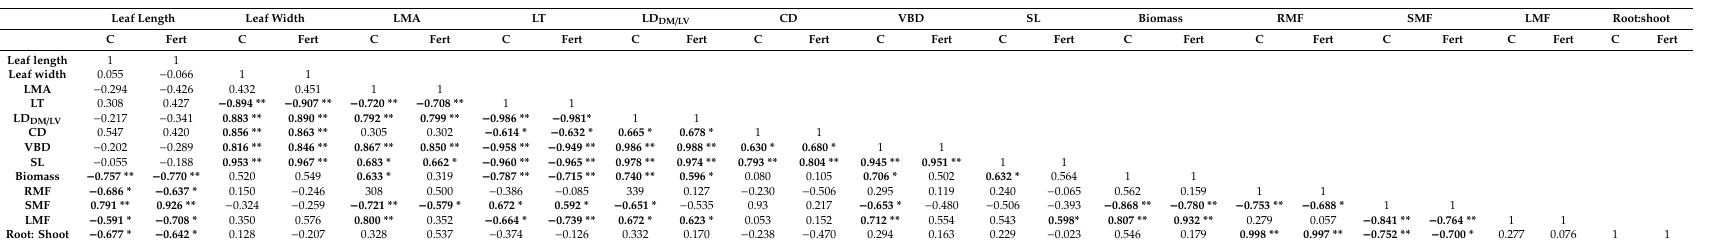
Table 3. Pearson’s correlation coe ffi cients of selected leaf morphological and anatomical traits, biomass and mass fractions of two-year-old seedlings of Fraxinus mandshurica , Tilia amurensis , Larix gmelinii , and Pinus koraiensis at control (C; no additional deposition) and after 10 g N m − 2 yr − 1 (Fert) additional nitrogen deposition in NE China. Abbreviations: leaf mass per area (LMA), leaf thickness (LT), leaf density measured (LD DM / LV ), conduit diameter (CD), vascular bundle diameter (VBD), stomata pore length (SL), root mass fraction (RMF), stem mass fraction (SMF) and leaf mass fraction (LMF), see text for details. See Supplementary Tables S3 and S4 and for separate Pearson correlation tables for angiosperms and gymnosperms, respectively. LeafLength LeafWidth LMA